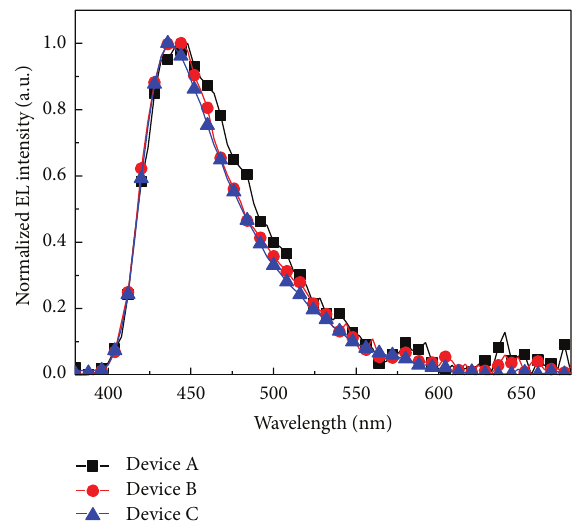
Figure 3: The luminance efficiency-current density characteristics of the devices A–C.